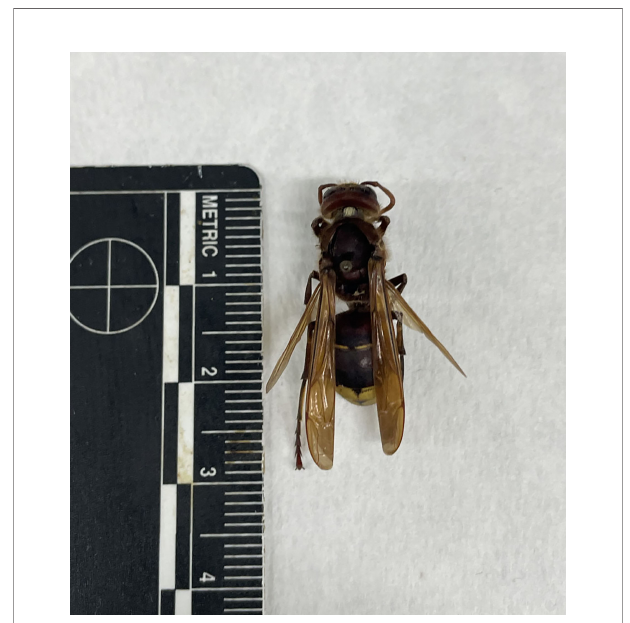
FIGURE 1 | Adult individual of Vespa orientalis showing the typical yellow bands of the abdominal